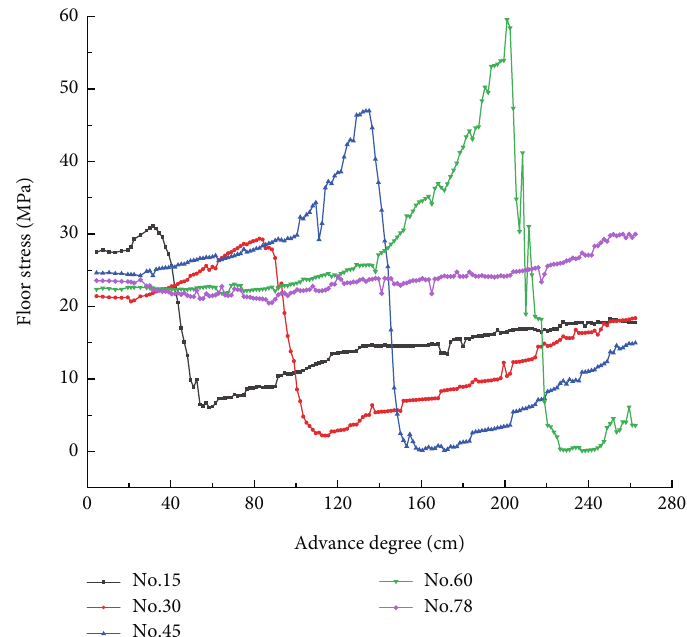
Figure 16: Pressure changes at di ff erent measuring points with the advancing of the 2301 working face.